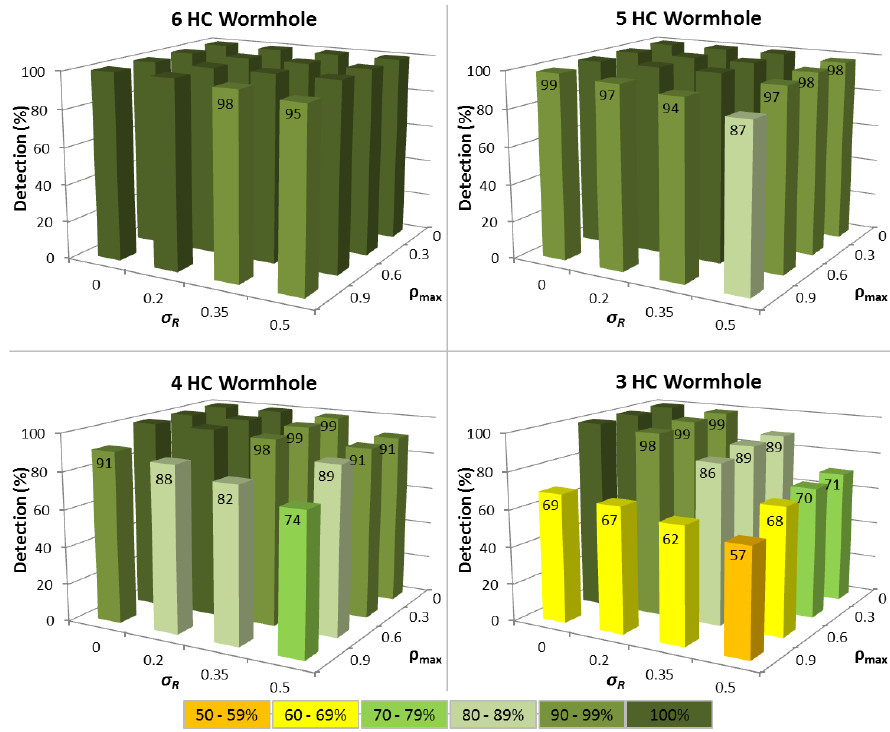
Figure 3. Time tampering detection performance for different wormhole HC for variable network traffic loads ( ρ ) and routing packet service times ( σ max samples available.